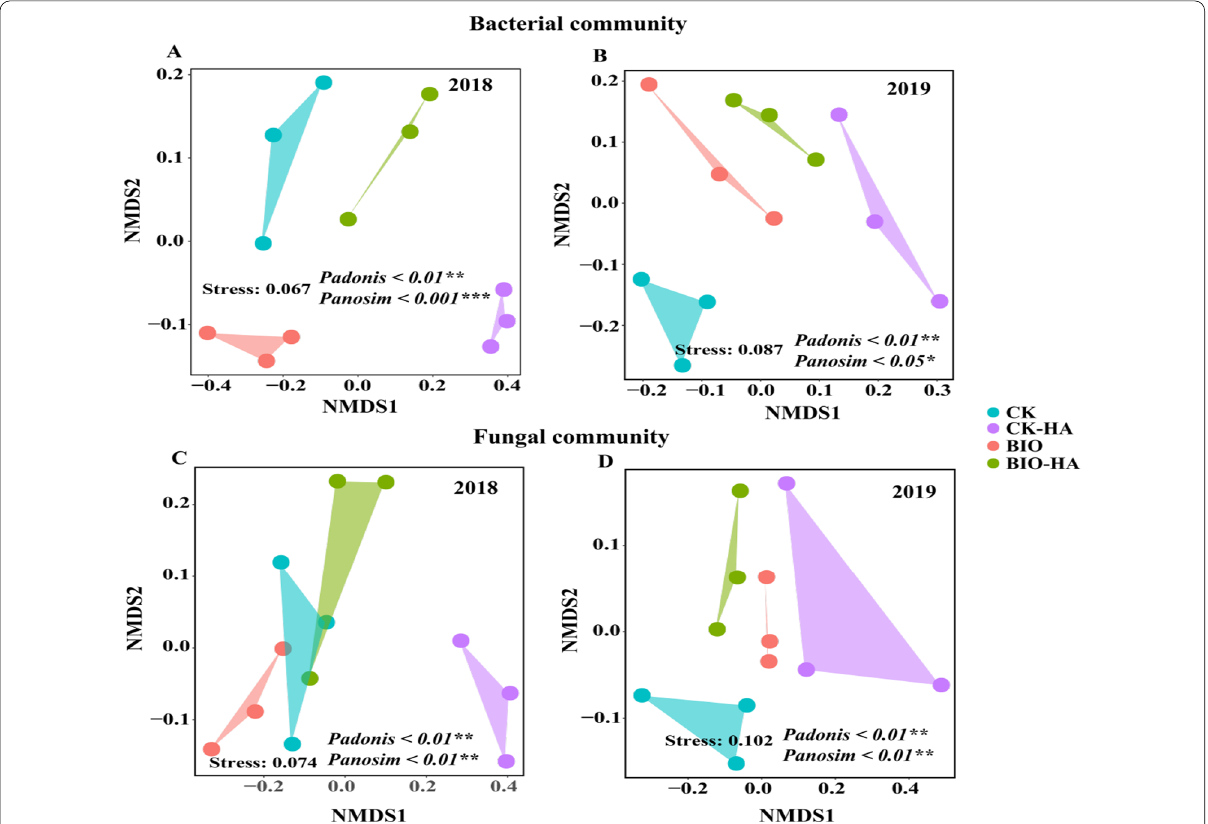
Fig. 2 Bacterial ( A and B ) and fungal ( C and D ) communities in soil treated with organic amendments. CK, conventional fertilization; CK-HA, conventional fertilization combined with humic acid; BIO, bio-organic fertilizer; BIO-HA, combined application of BIO and HA. *P < 0.05; **P < 0.01; ***P <